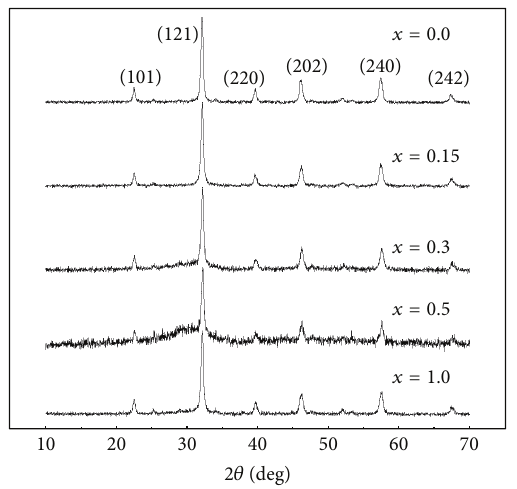
Figure 1: XRD patterns of La 1−𝑥 Nd 𝑥 FeO 3 nanoparticles after annealing in air at 500 ∘ C for 10 hours.